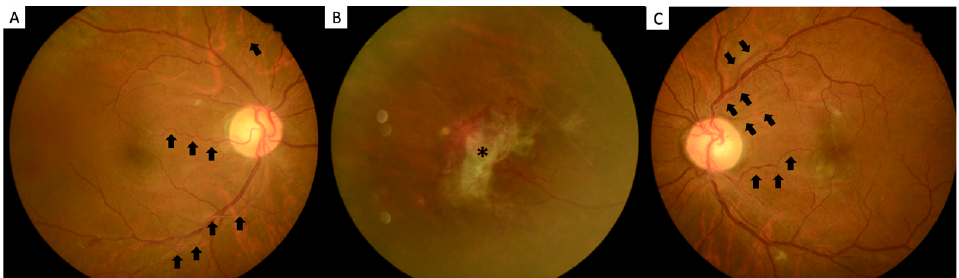
Figure 1. ( A ) Tortuous retinal artery (arrow) and venous sheathing in the right eye; ( B ) Fibrovascular membrane with hemorrhage (asterisk) in the right eye; and ( C ) Tortuous retinal artery (arrow) in the left eye.